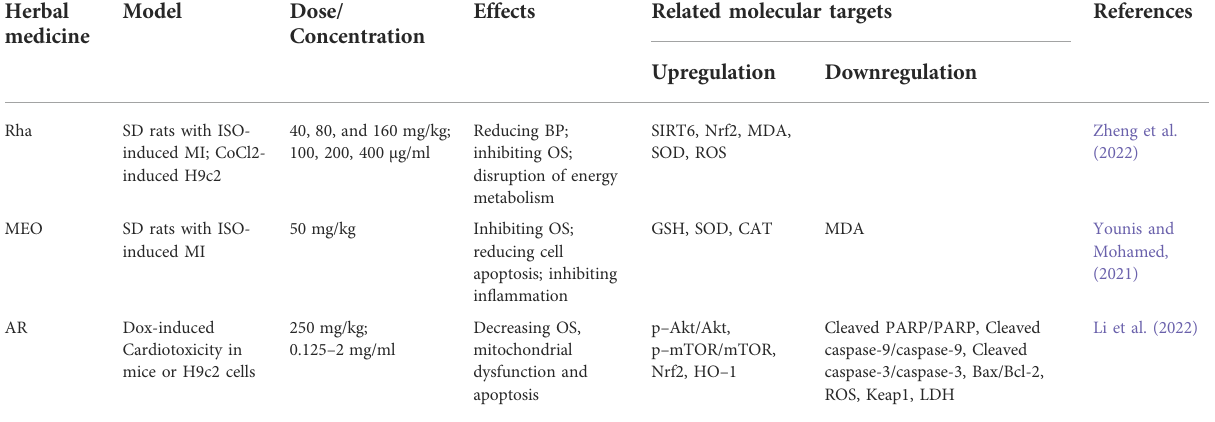
TABLE 1 Protective effects of herbal medicinal extracts in vascular endothelial cells. Herbal